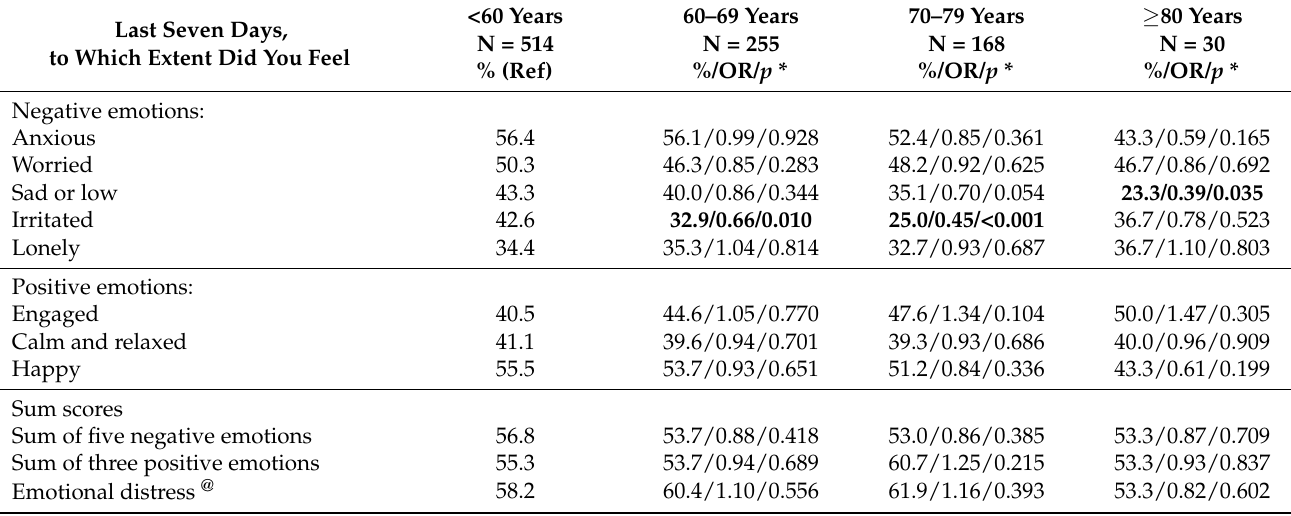
Table 2. Percentage of respondents with negative change in emotions from spring 2019 to COVID-19 wave March 2020 in The Norwegian Citizen Panel (N: